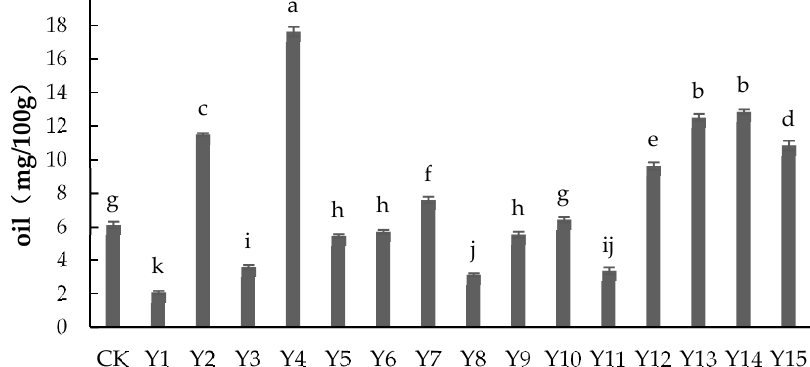
Figure 3. The content of total flavonoid in Camellia oil under different treatments. Note: Data indicate mean ± SE ( n = 3). Different letters indicate significant differences ( p < 0.05) between different treatments.